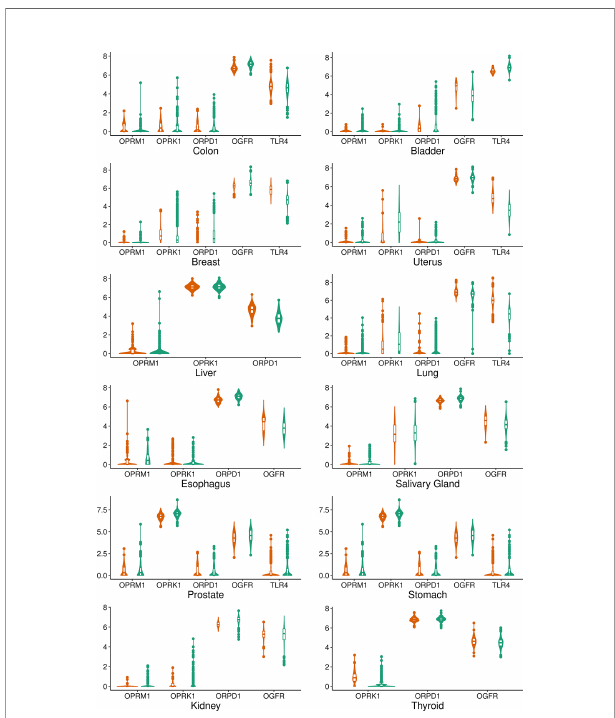
FIGURE 2 | Violin and box plot graphs of the expression of opioid receptors genes by tumor type. Green: tumor samples. Orange: control samples. MOR,